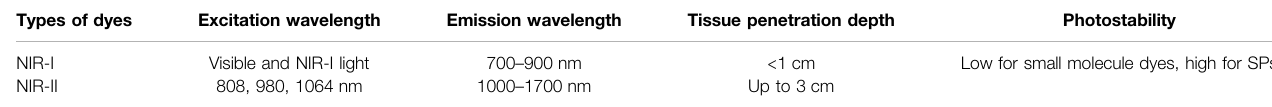
TABLE 1 | General comparison between NIR-I and NIR-II